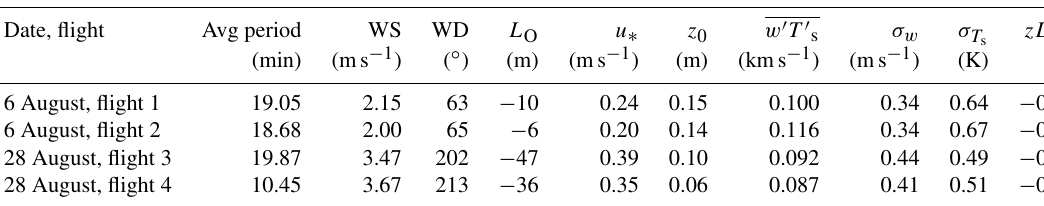
Table 2. Summary of the mean micrometeorological parameters determined at the EC station, where σ χ indicates the standard deviation of an arbitrary flow variable χ .